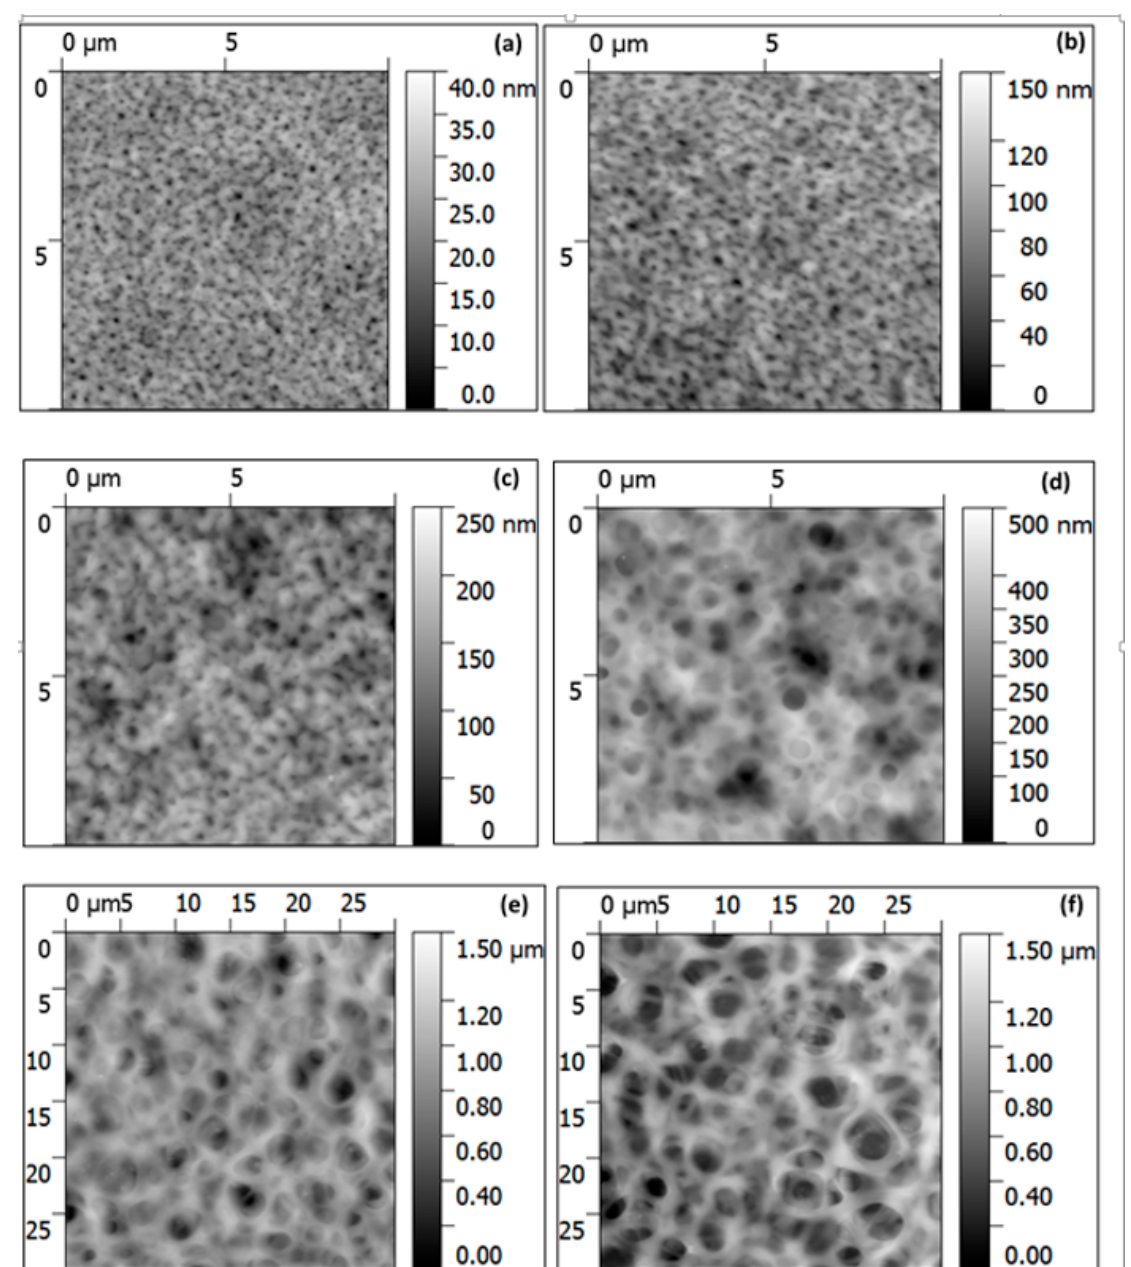
Figure 1. AFM topographical images of polymer films as deposited on silicon wafer by dip-coating: ( a ) PAN/PET-10-25, ( b ) PAN/PET-20-25, ( c ) PAN/PET-25-25, ( d ) PAN/PET-30-25, ( e ) PAN/PET-35-25, and ( f ) PAN/PET-40-25. The scale bar on the right side of the AFM images depicts the height scale of the image, where light and dark shades correspond to high and low relative heights, respectively.